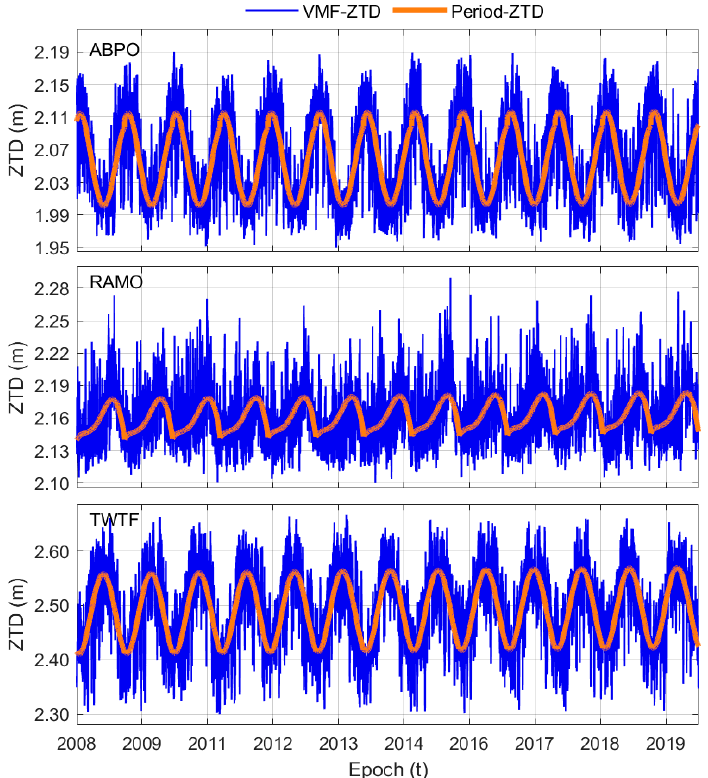
Figure 7. VMF-ZTD time-series trends from 2008 to 2020 at ABPO, RAMO, and TWTF stations, respectively.